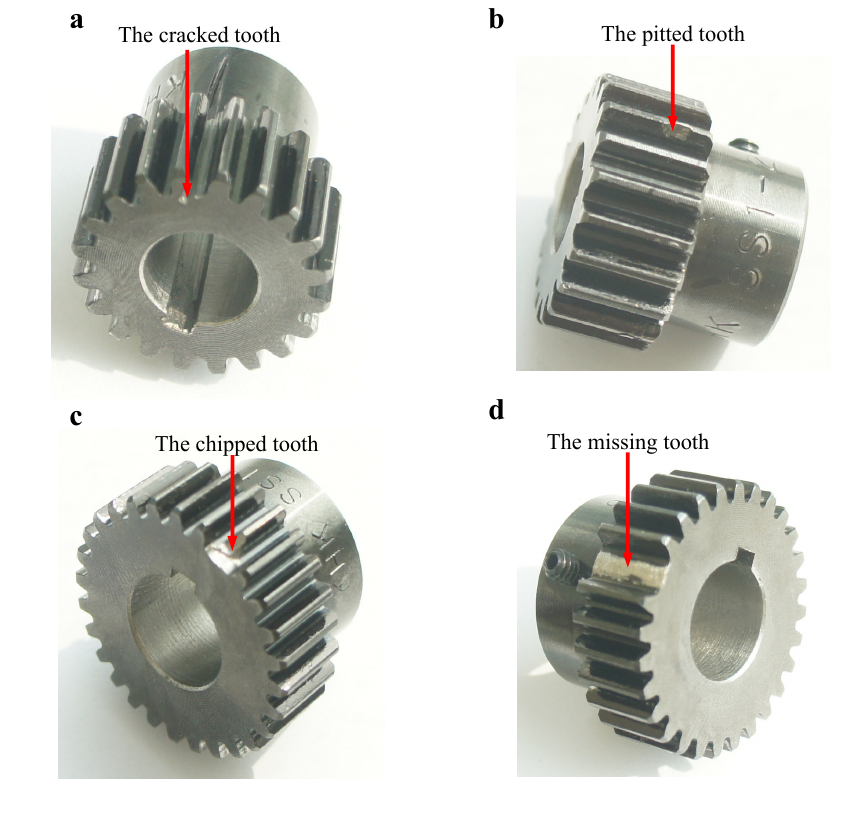
Figure 4. Damaged sun gears: ( a ) having a cracked tooth; ( b ) having a pitted tooth; ( c ) having a chipped tooth; and ( d ) having a missing